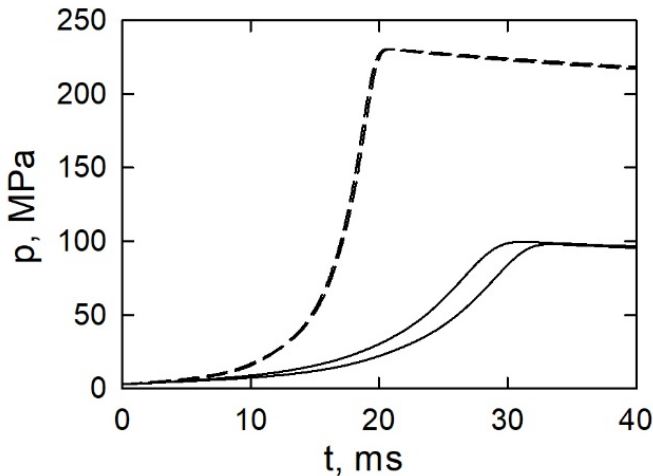
Figure 3. Propellant gases pressure courses obtained for loading density of 100 kg/m 3 (solid line) and 200 kg/m 3 (dashed line). Table 2. Estimated equation of state parameters for propellant gases.